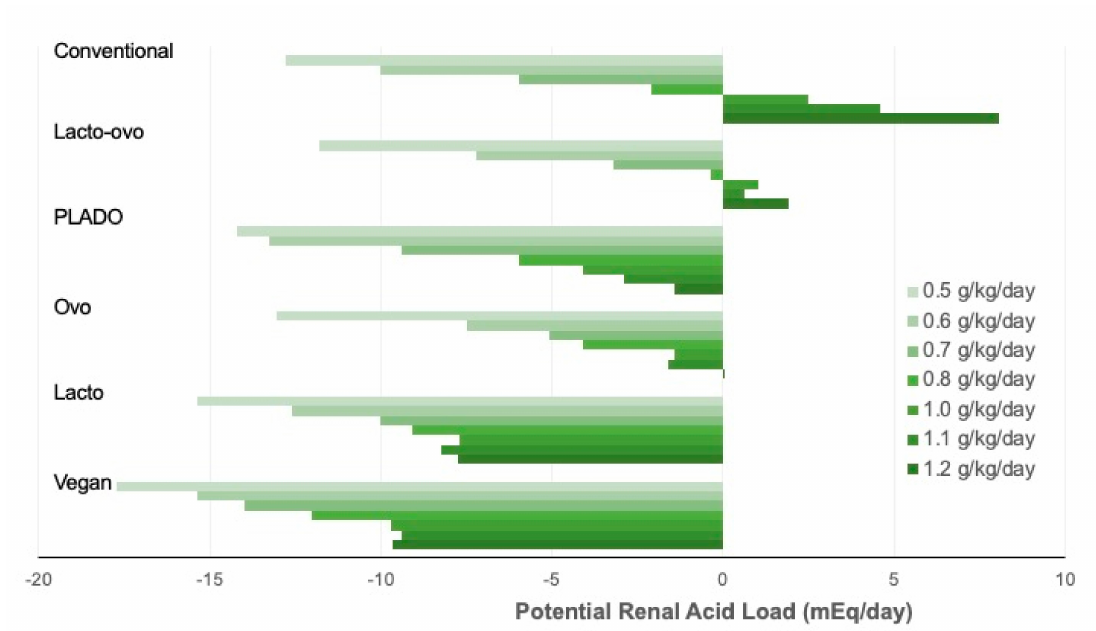
Figure 2. Potential renal acid load of all types of diets at different levels of protein